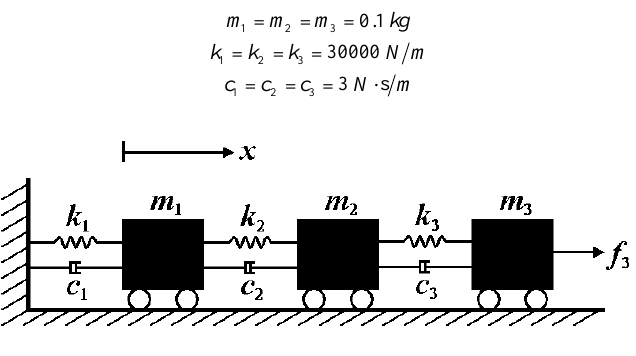
Fig. 1. A Mass-Spring-Damper